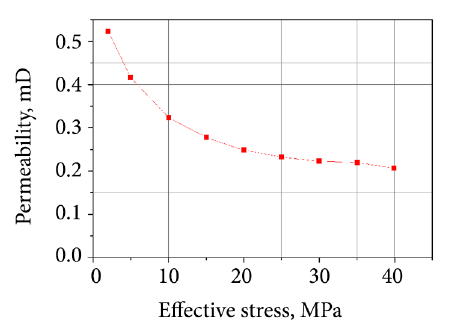
Figure 2. Reservoir rock stress sensitivity